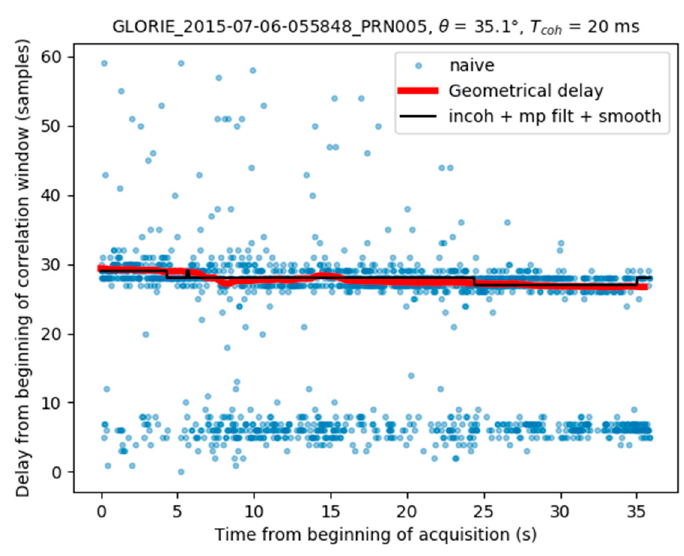
Figure 13. Comparison of the obtained peak location with the geometrical delay.